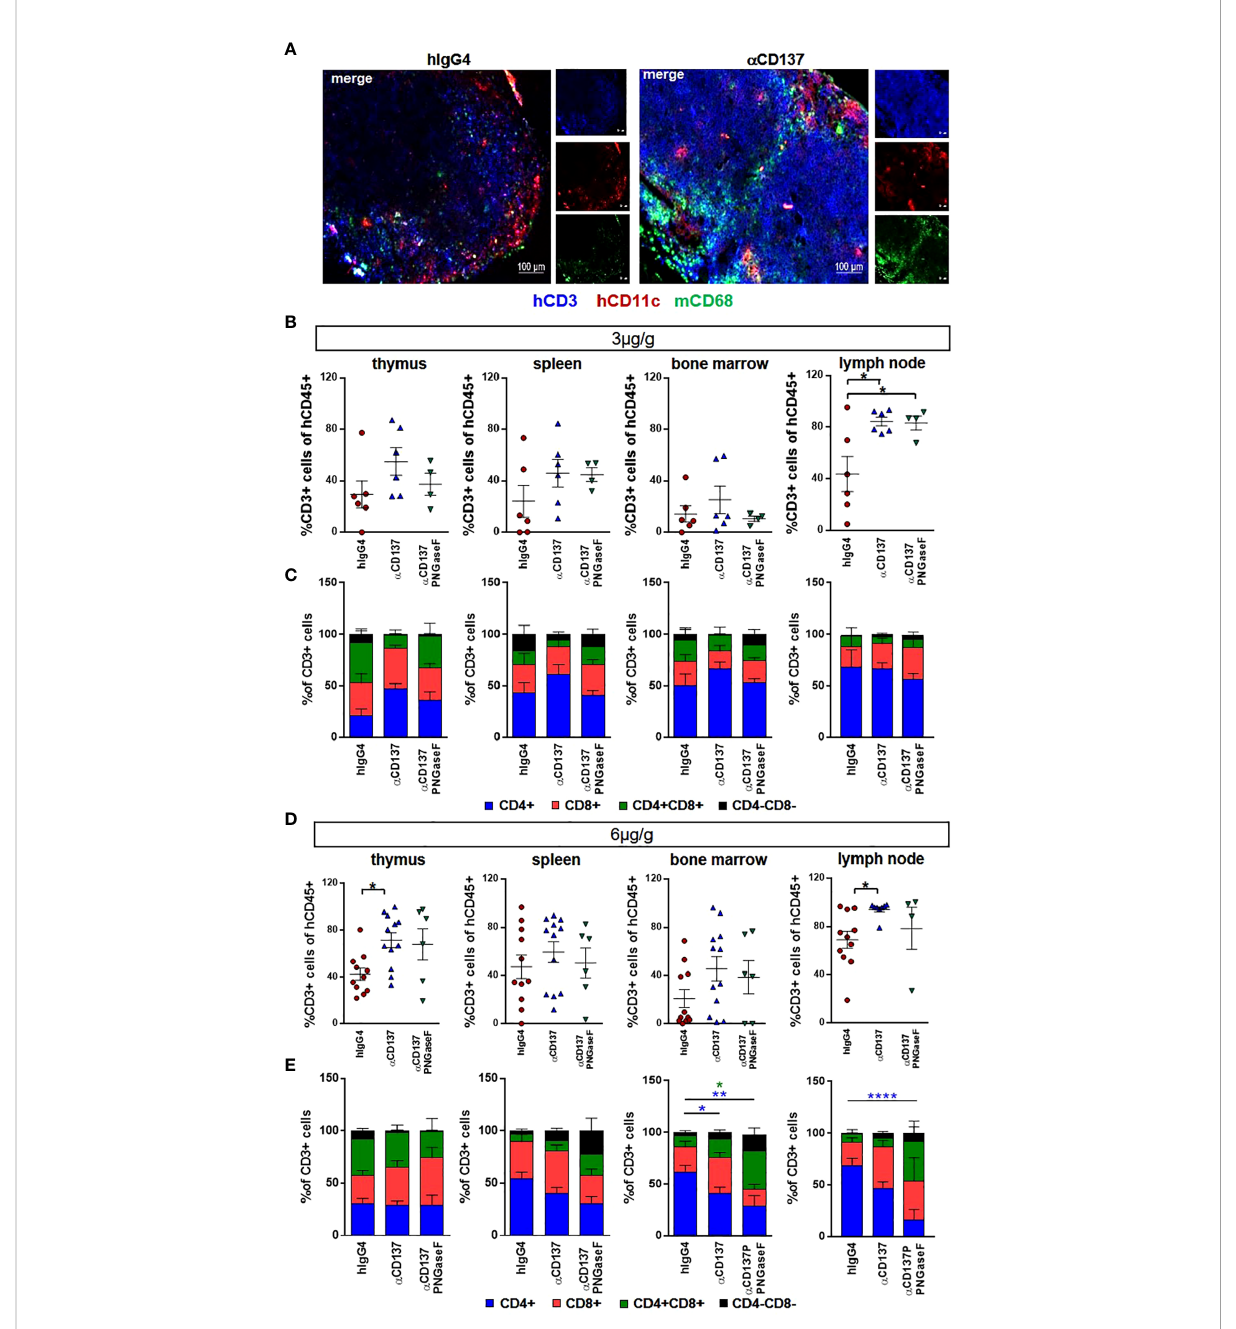
FIGURE 4 Effect of urelumab variant treatment on T cells in primary and secondary immunological organs. Humanized mice received either 3 or 6µg/g of a human IgG4 isotype control, urelumab ( a CD137) or deglycosylated urelumab ( a CD137 PNGaseF) and were studied for twenty days after antibody injection. (A) Shown are representative immuno fl uorescent stainings of lymph node sections of mice treated with 6µg/g hIgG4 as a control or with urelumab ( a CD137) identifying human T cells (hCD3), human dendritic cells (hCD11c), as well as mouse macrophages (mCD68). (B, C) Depicted are relative amounts of human CD3+ cells (B) and of different T cell subsets (C) in thymus, spleen, bone marrow, and lymph nodes of mice treated with 3µg/g of the indicated antibodies (hIgG4: n= 6; a CD137: n=6; a CD137 PNGaseF: n=4). (D, E) Depicted are relative amounts of human CD3+ T cells (D) and of different T cell subsets (E) in thymus, spleen, bone marrow, and lymph nodes of mice treated with 6µg/g of the indicated antibody variants (hIgG4: n= 11; a CD137: n=8-12; a CD137-PNGaseF: n=4-6). Shown is the combined data from two to three independent experiments and results are represented as mean +/- SEM. Statistical analysis was done by Shapiro-Wilk normality test, Kruskal-Wallis with Dunn ’ s multiple comparison test or 1-way ANOVA. For analysing T cell subsets a 2-Way ANOVA was performed. *p<0.05; **p<0.01;